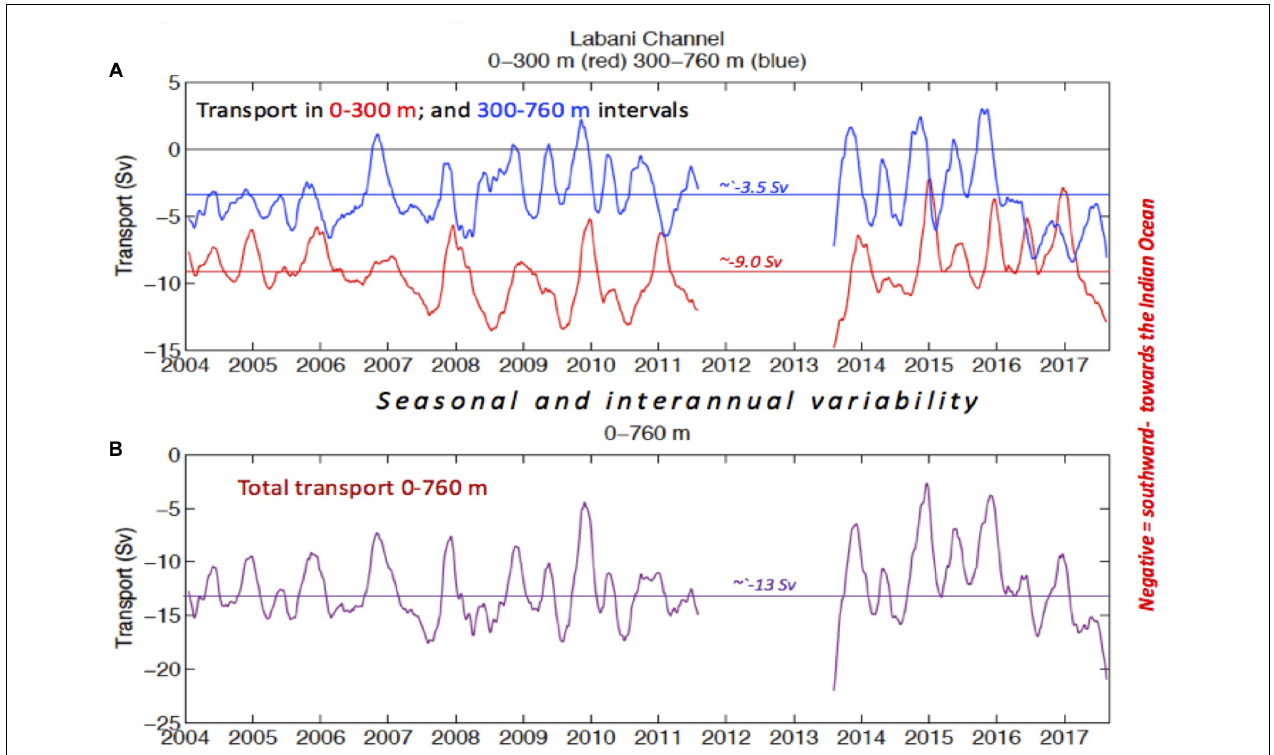
FIGURE 4 | (A) Volume transport in Sv (Sv, Sverdrup = 10 6 m 3 /sec) for the 0–300 m interval (red) and 300–760 m interval (blue) and (B) the total transport 0–760 m (purple). Negative flow is southward toward the Indian Ocean (Figure from Gordon et al.,